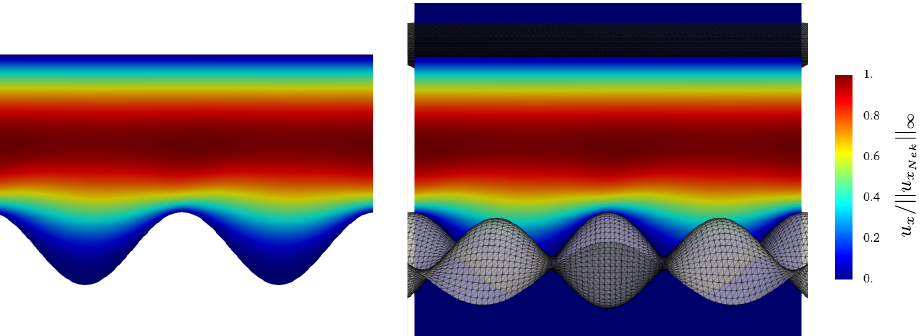
|| ∞ at the steady state on a plane located at z = 1.19 orthogonal to Figure 11. Contours of u x / || u x Nek the z axis. Left: Nek5000, right: Direction Splitting, h s / ∆ x = 96.